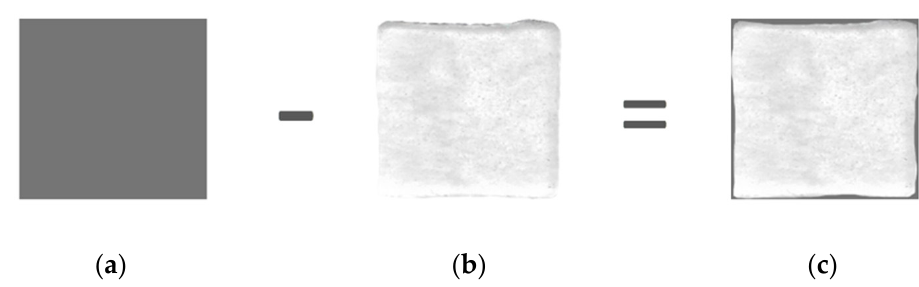
Figure 2. ( a ) Theoretical film dimensions, ( b ) 3D-printed film dimensions immediately after printing and ( c ) their difference as calculated by Equation (7).